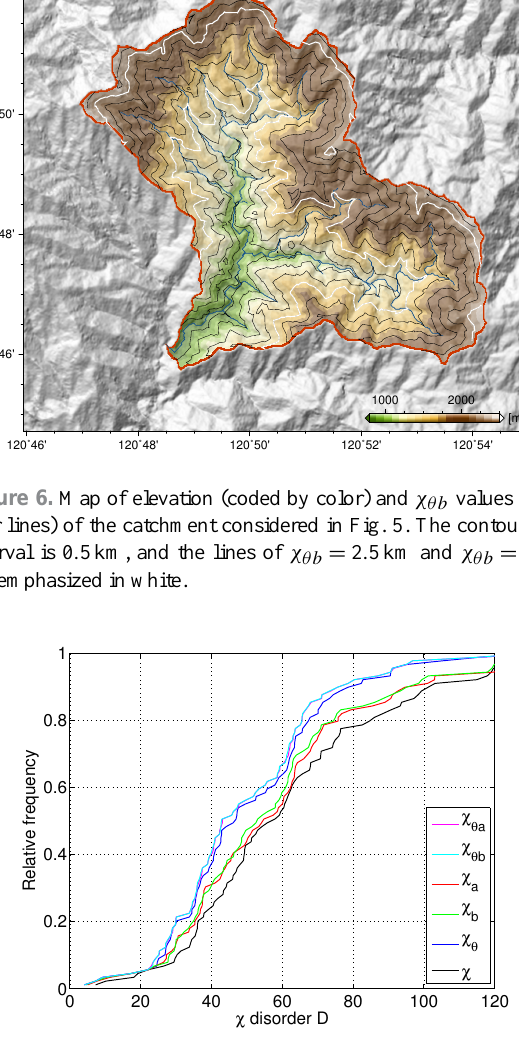
Figure 7. Cumulative distribution of the χ disorder for the 89 considered catchments in Taiwan for 1 km 2 ≤ A ≤ 100 km 2 . Each curve describes the relative number of the catchments with a χ dis- order lower than or equal to the value D on the x